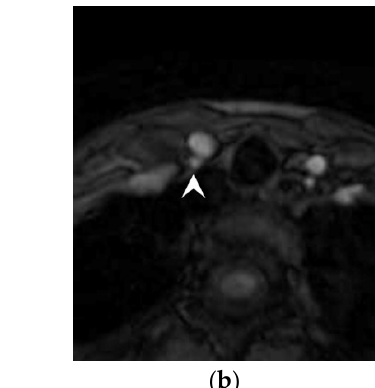
Figure 8. The dual origin of the RVA. ( a ) Right anterior oblique view of the magnetic resonance angiography (MRA) shows the dual origin of the RVA. The abnormal VA originates from the RCCA (white arrowhead). ( b ) Axial views of the source image of the MRA show the abnormal VA (white arrowhead) originating from the common carotid artery and the normal vessels from the RSCA.